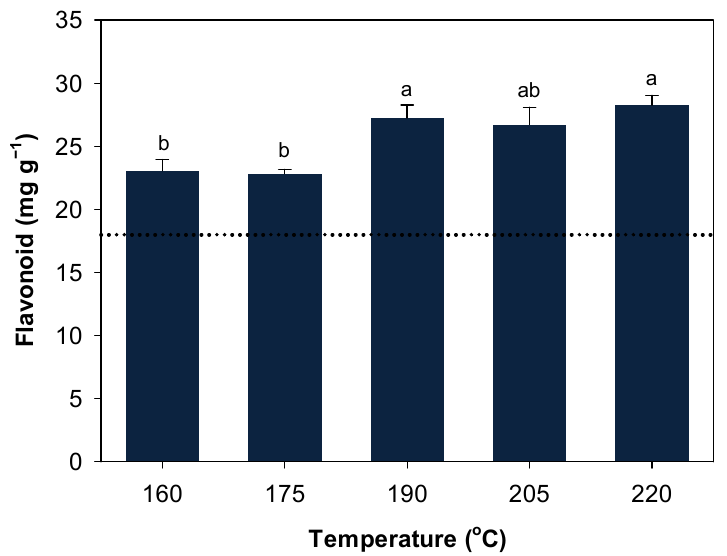
Figure 2. Concentration of total flavonoid as affected by main effect of temperature. Data represents mean ± SE. The dotted line represents untreated control. Means followed by different lower-case letters indicate significant differences at α = 0.05. Table 3. Concentration of total phenol and total alkaloid as affected by temperature × retention time